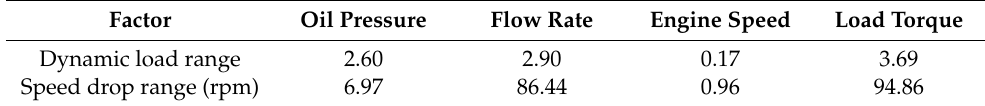
Table 3. Calculation results based on the range analysis.